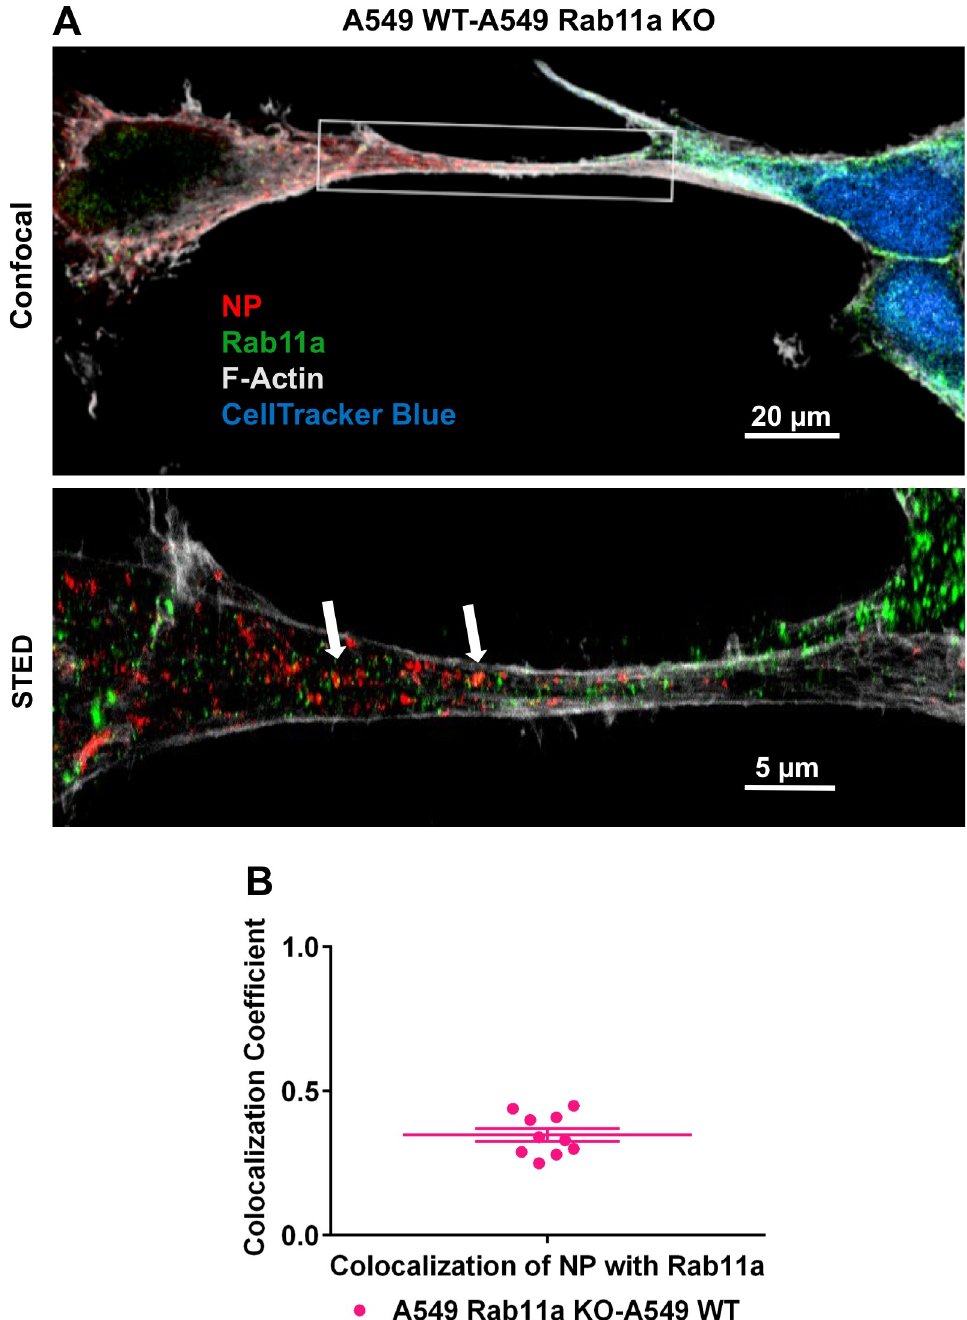
Fig 6. TNTs allow for bidirectional shuttling of Rab11a between cells. [A]A549 Rab11a KO cells were infected with NL09 viruses and mixed with A549 WT cells pre-stained with CellTracker Blue CMAC dye [blue]. Cells were stained for NP [red], Rab11a [green] and F-Actin [grey]. Representative confocal image is shown with the high-resolution STED images depicted in the inset. [B] Co-localization coefficient of NP and Rab11a within TNTs formed between A549 WT and Rab11a KO cells [n = 10 TNTs]. Error bars represent the SEM of two biological replicates with two technical replicates each.